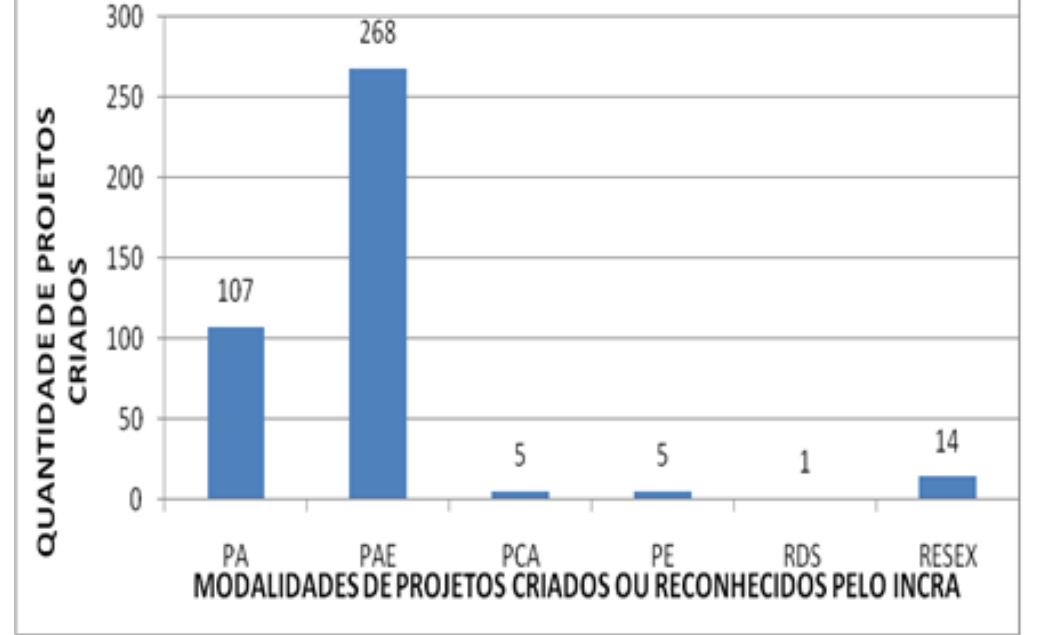
Figura 1. Gráfico Quantitativo atual de projetos criados e∕ou com famílias beneficiárias pelo INCRA